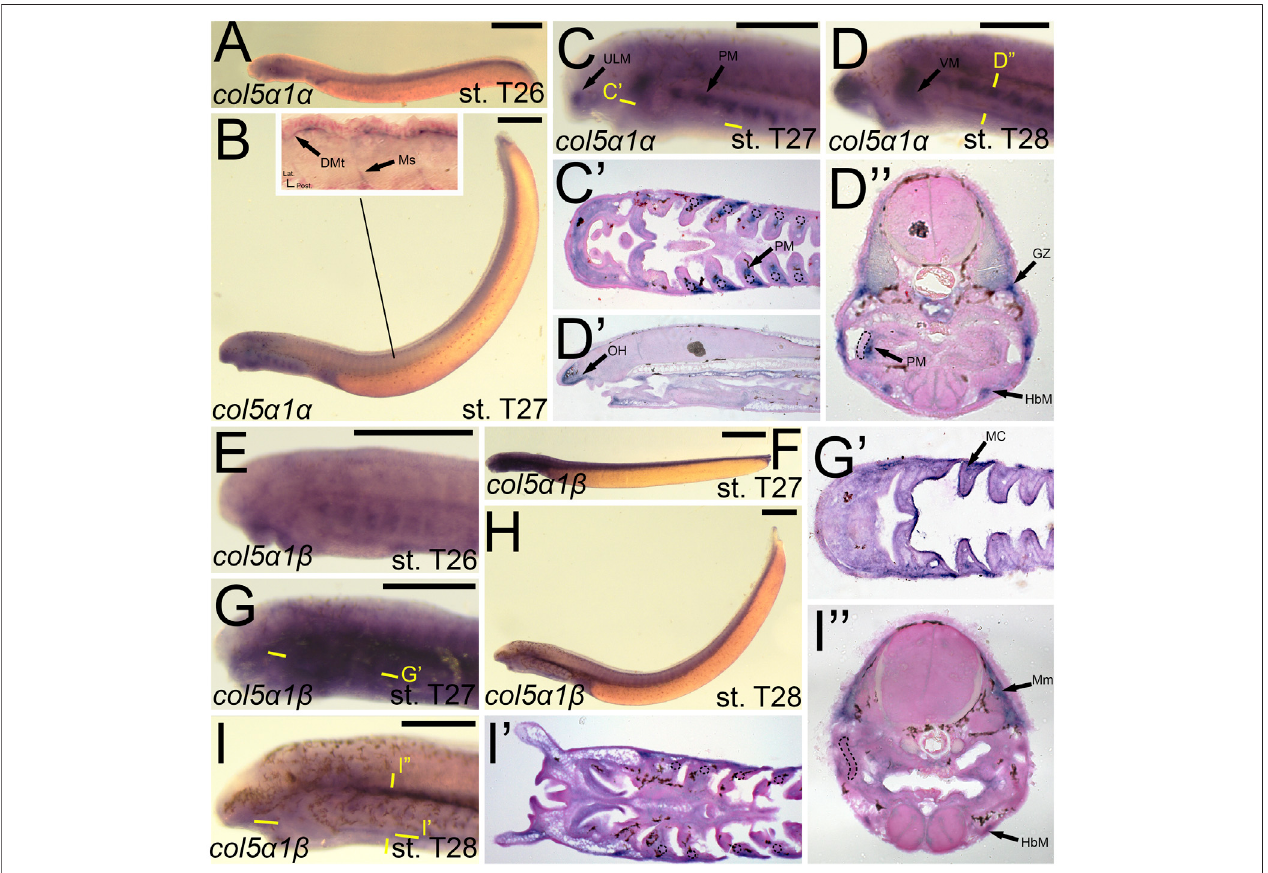
FIGURE9| Expressionof colB1/col5a1 α and colB2/col5a1 β inlarvallamprey.Allscalebarsareapproximately500 μ m. (A) col5a1 α expressionwasprimarilyinthe developingheart. (B,C) col5a1 α expressionwasinthemusculatureofthepharynx,velum,andupperlip,andwasalsointhedermomyotomeandmyosepta. (D) col5a1 α expressionwasinthemesenchymeoftheoralhood,thegrowthzone,dermomyotome,hypobranchialmusculature,andthepharyngealmuscles.Dottedcirclesindicate presumptivebranchialarchskeleton. (E) col5a1 β expressionwasintheoralectodermandthroughoutthepharynxalbeitatlowlevels (F,G) col5a1 β expressionwas in the mesodermal core of the pharynx and throughout the pharynx albeit at low levels. (H,I) col5a1 β expression was in the hypobranchial musculature as well as the myomeres. Dotted circles indicate presumptive branchial arch skeleton. Keywords: DMt: dermomyotome; GZ: growth zone; HbM: hypobranchial musculature; MC: mesodermal core; Mm: myomeres; Ms: myosepta; OH: oral hood; PM: pharyngeal muscle; ULM: upper lip muscle; VM: velar